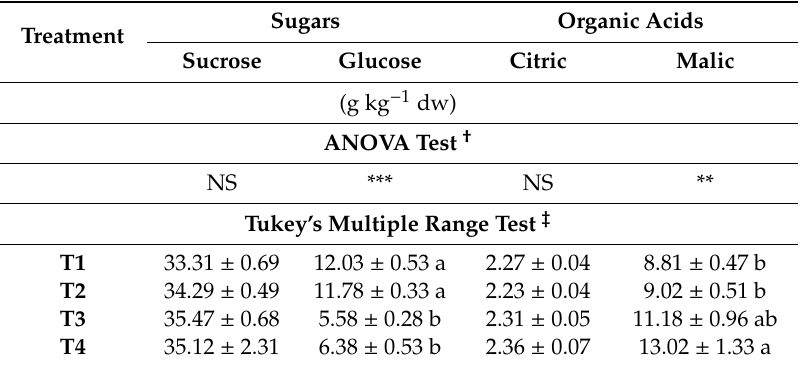
Table 1. Sugars and organic acid profiles and contents (g kg − 1 dry weight (dw)) of raw almonds as a ff ected by deficit irrigation